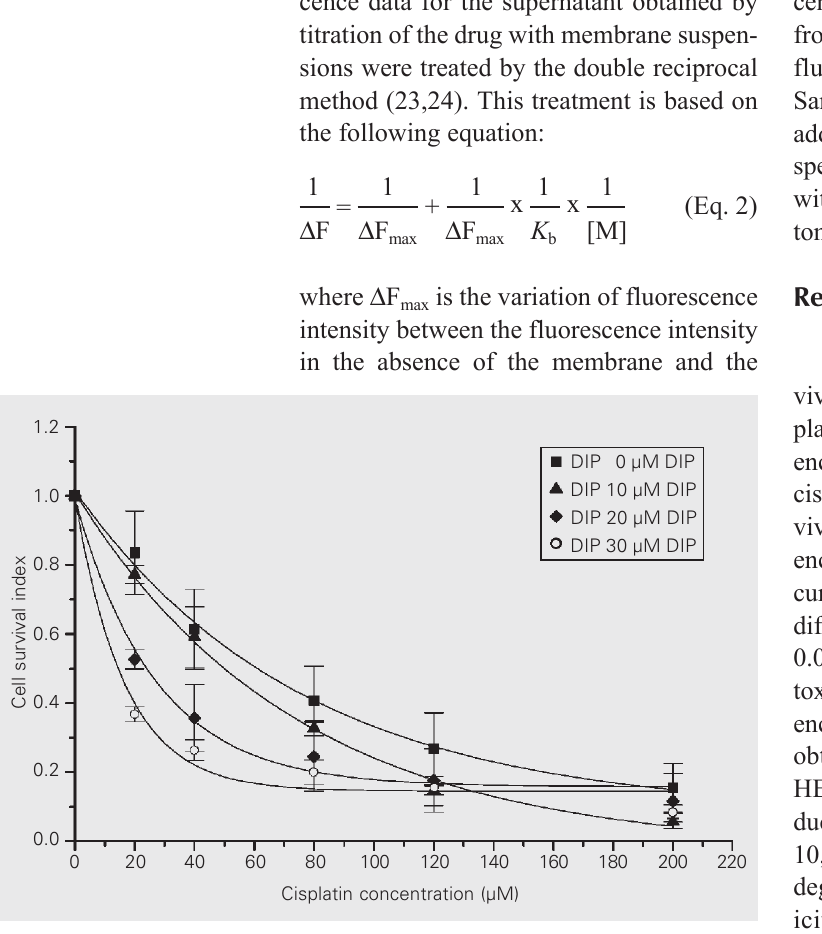
Figure 1. Survival index of HEp-2 cells as a function of cisplatin concentration in combination with dipyridamole (DIP). Cells were treated with several cisplatin concentrations (0, 20, 40, 80, 120 and 200 µM) combined with fixed DIP concentrations (0, 10, 20 and 30 µM) for 1 h at 37 º C in the presence of 5% CO 2 . Data are reported as means ± SD for 5-13